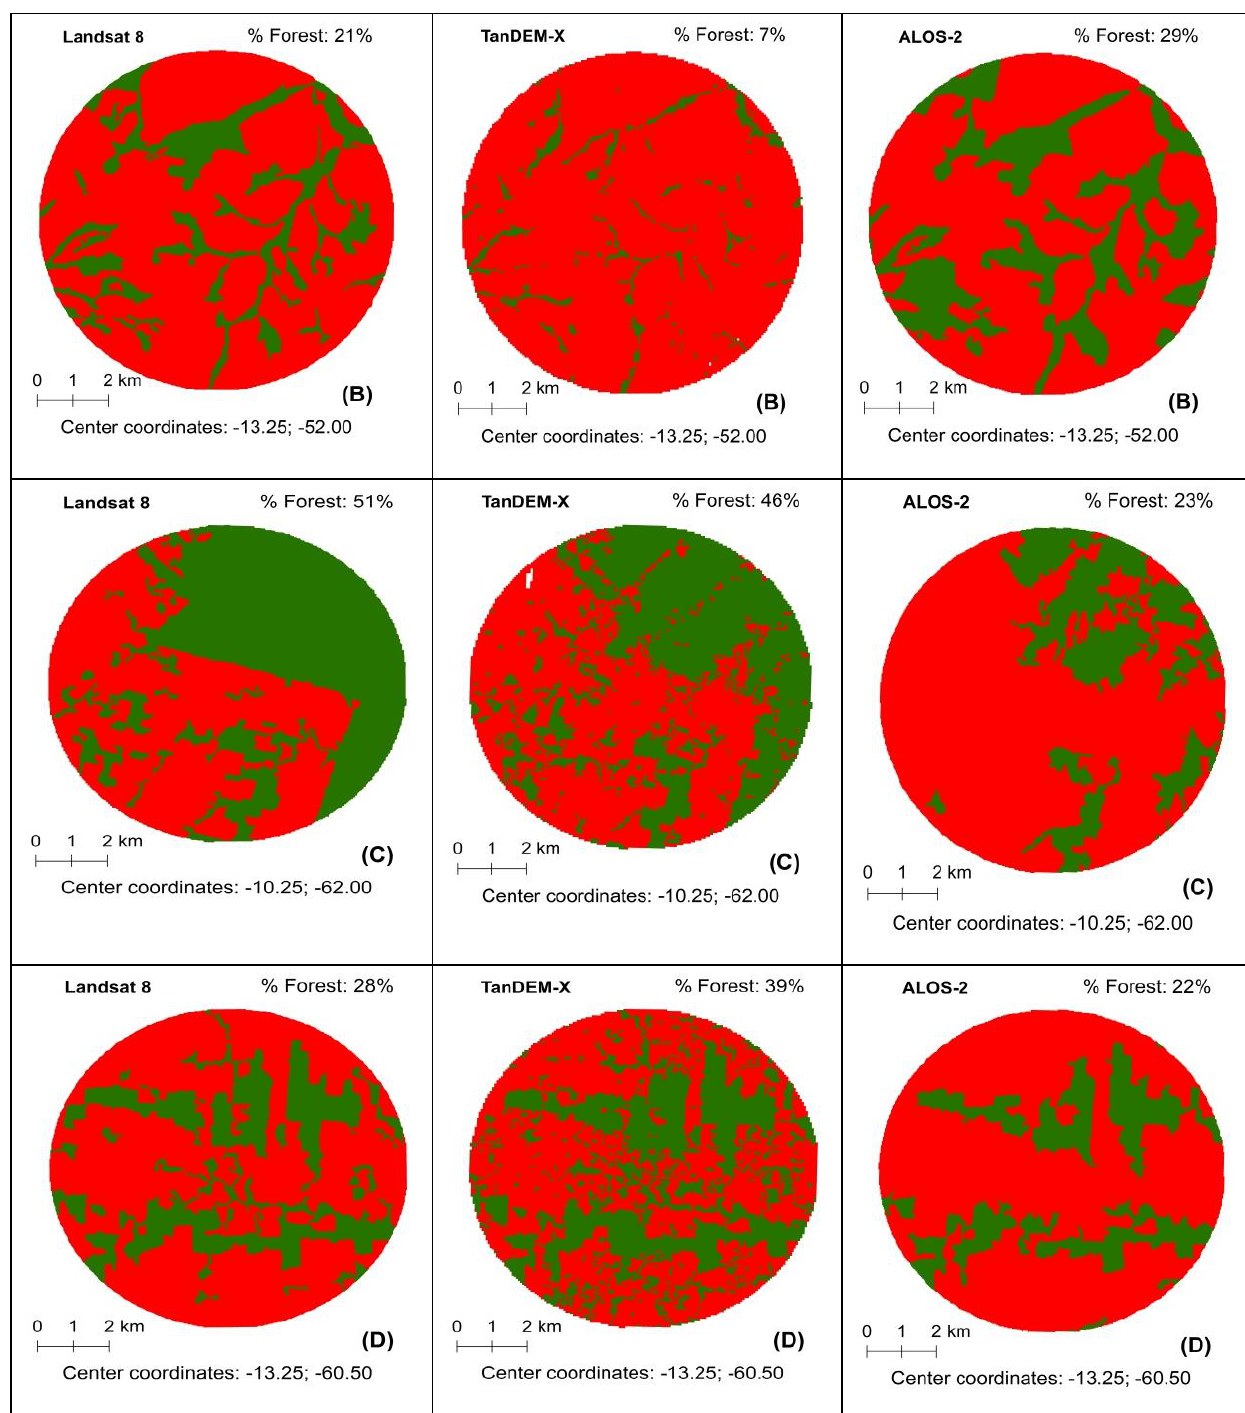
Figure 10. Examples of forest estimations obtained by the TanDEM-X and ALOS-2 data sets over the Amazon biome showing cases of TanDEM-X forest underestimation in the municipalities of Nova Canaã do Norte ( A ) and Canarana ( B ), Mato Grosso State, as well as cases of ALOS-2 forest underestimation in the municipalities of Vale do Paraíso ( C ) and Colorado do Oeste ( D ), Rondônia State. The corresponding forest estimations from Landsat 8 are shown in the first column. Green = forest; red = non-forest; blue = water body.